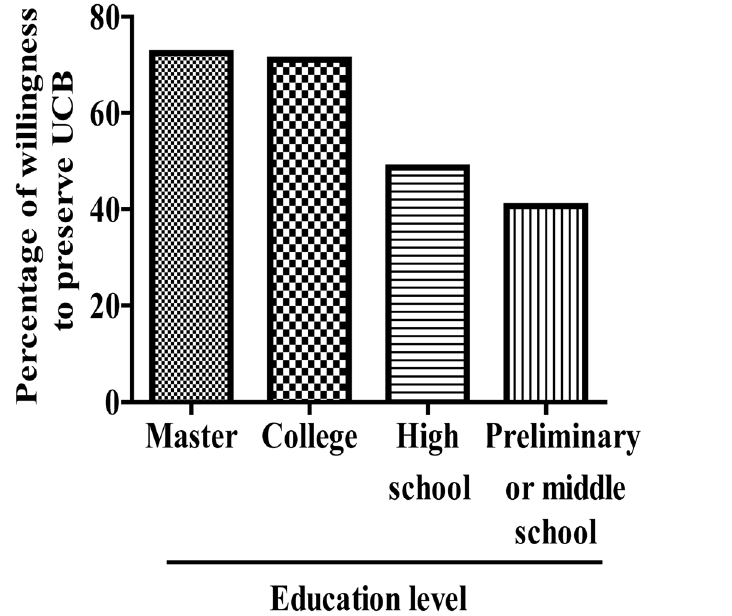
Fig 3. Effect of education level on willingness to preserve UCB.